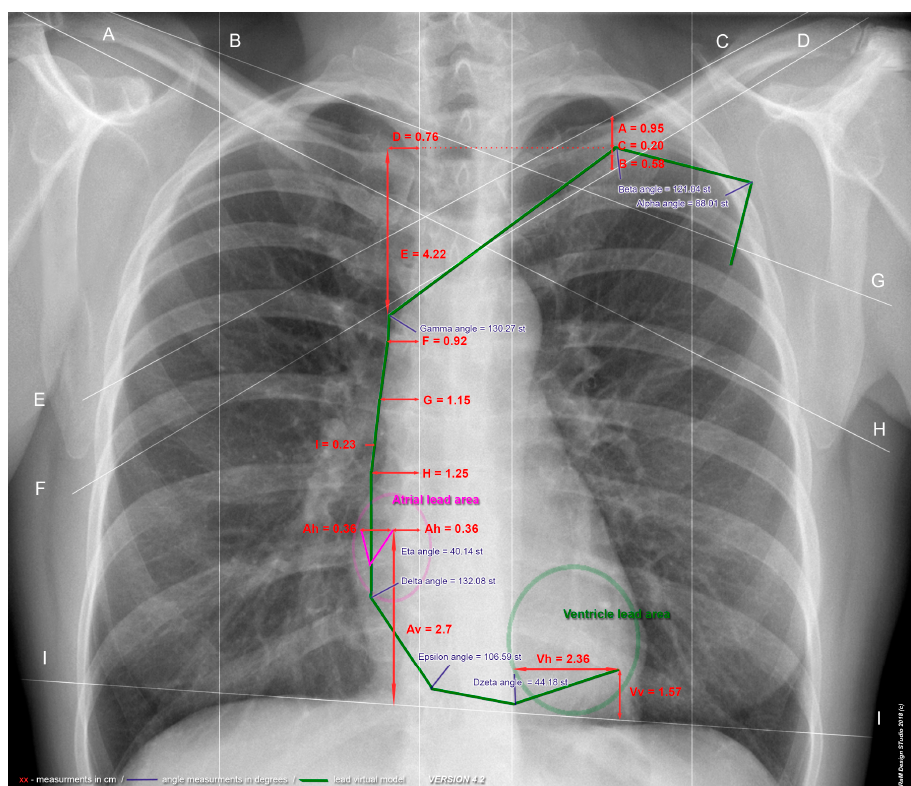
Figure 2. Two-dimensional model of the average course of the leads based on an example of an X-ray image in a PA projection (posterior–anterior). Distance measurements in cm; Angle measurements in degrees. ( A ) Midclavicular line—right; ( B ) Lateral sternal line—right; ( C ) Lateral sternal line—left; ( D ) Midclavicular line—left; ( E ) Upper clavicular line—left; ( F ) Lower clavicular line—left; ( G ) Upper clavicular line—right; ( H ) Lower clavicular line—right; ( I ) Diaphragm dome line. Red letters are explained in Appendix A, Table